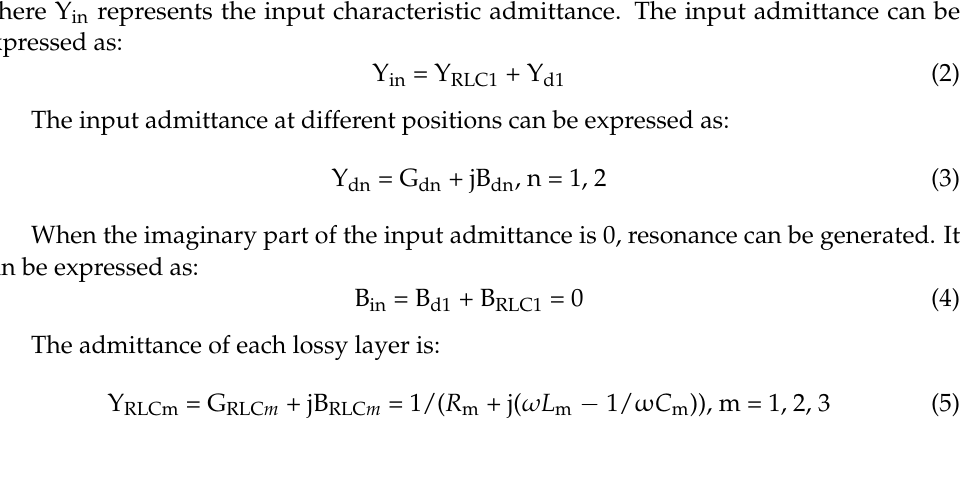
Figure 2. Equivalent circuit model of the proposed absorber unit.